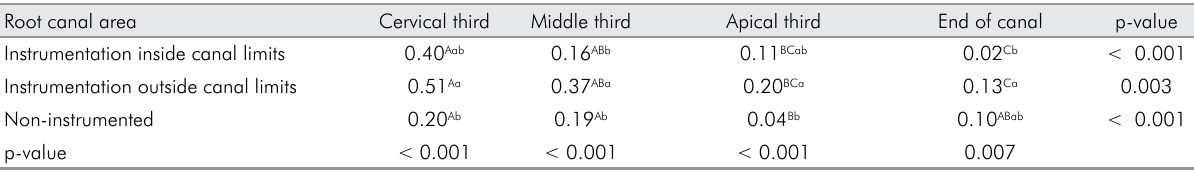
Table 1. Median values (mm²) for post-instrumentation measurements of canal areas in root cross-sections